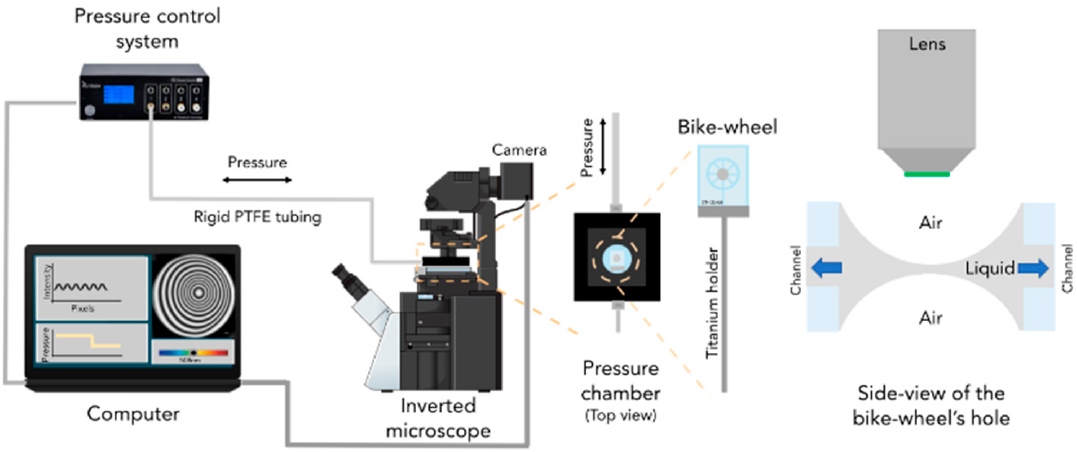
Figure 1. Scheme of the thin-film balance setup used in the film imaging experiments. Reprinted from [4].